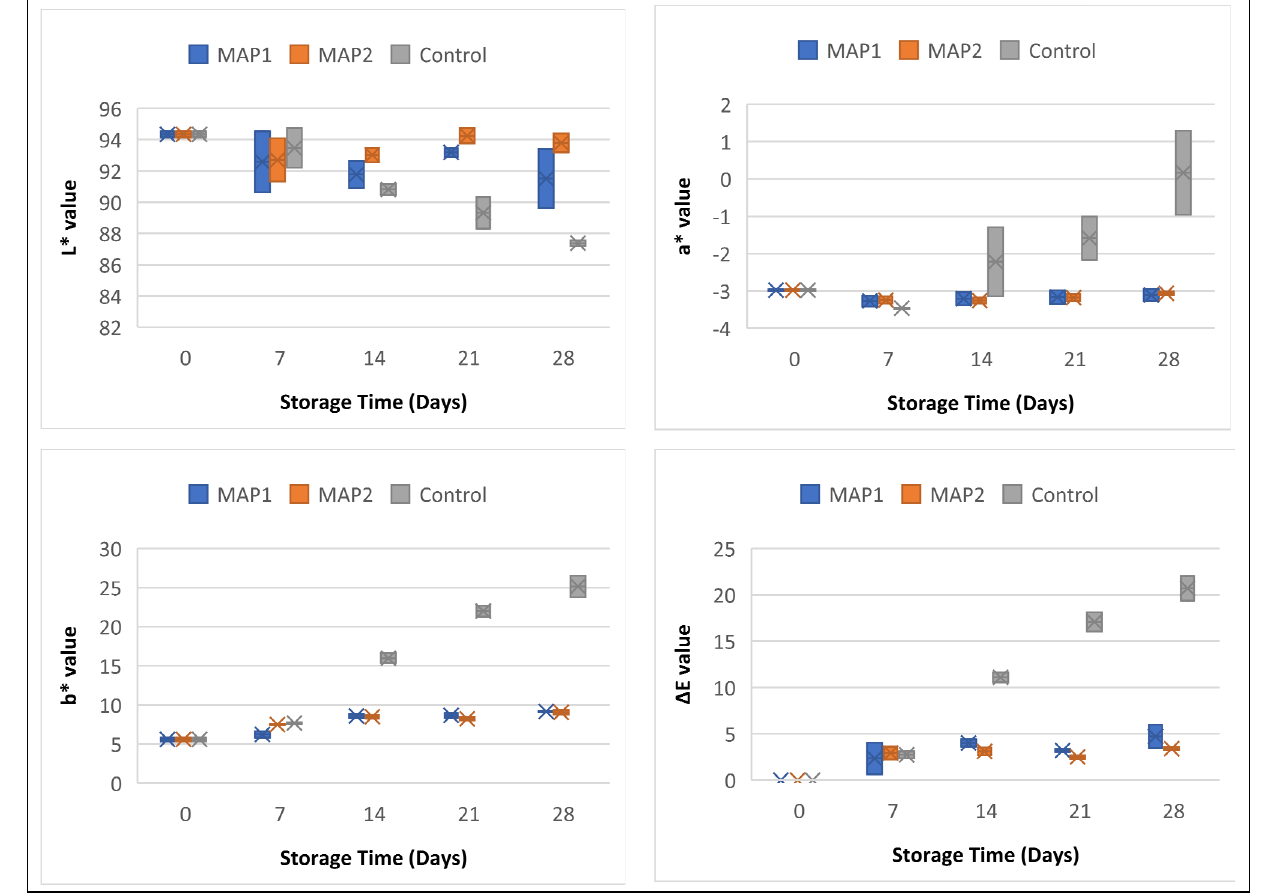
Figure 1. Color characteristics (L*, a*, b*, and Δ E) of CC samples. MAP1: %96 N 2 + %4 H 2 ; MAP2: %100 N 2 .